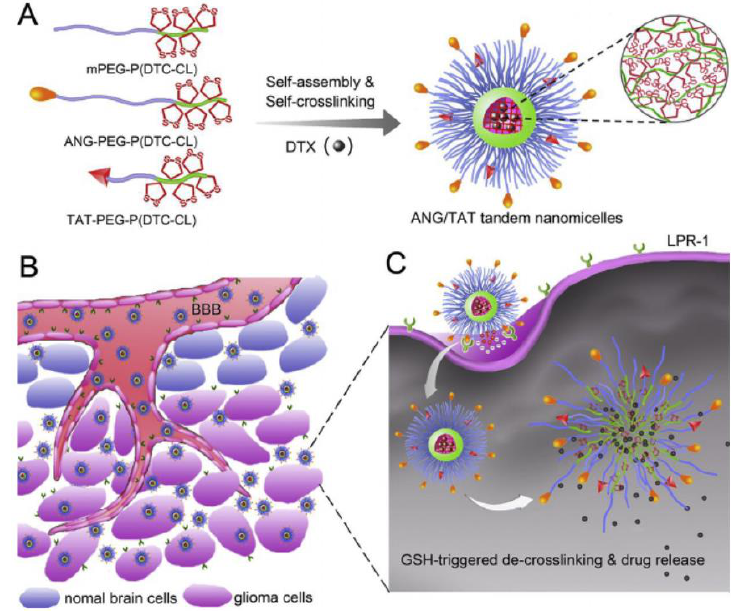
Figure 4. Illustration of tandem nanomicelles co-functionalized with brain tumor-targeting and CPPs (Angiopep-2 and TAT) for specific anti-glioma chemotherapy. ( A ) ANG/TAT-Ms micelles are assembled from PEG; ( B ) Tandem nanomicelles are able to cross blood-brain barrier (BBB) and target glioma cells; ( C ) Docetaxel (DTX) is released into the cytoplasm as a result of Glutathione (GSH)-triggered de-cross-linking of ANG/TAT-Ms. Adapted from Journal of Controlled Release with permission from correspondent’s authors Zhang, J., Feijen J. and Zhong Z., published by Elsevier 2018, Copyright 2018